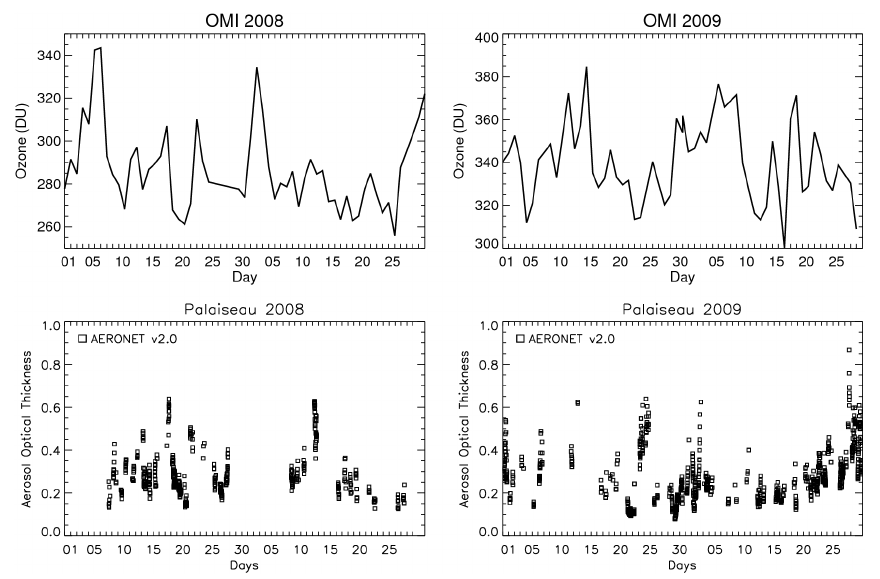
Fig. 1. Ozone (top) and aerosol optical thickness at 340nm (bottom) during the RISC-UV 1 (left) and 2 (right) campaign over SIRTA observatory. Ozone and aerosol measurements are provided by the AURA/OMI and AERONET teams,